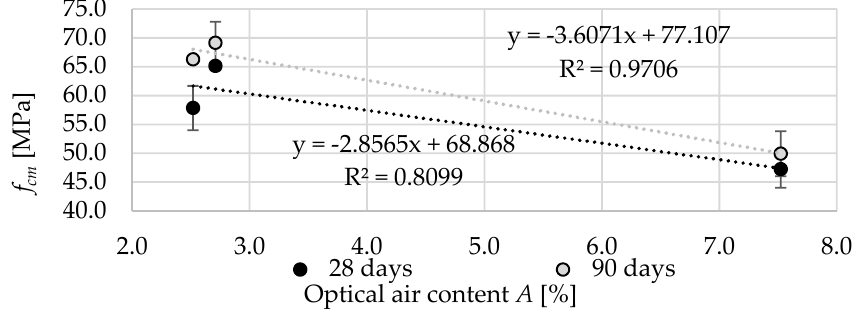
Figure 19. The relation between the optical air content A and compressive strength f cm .